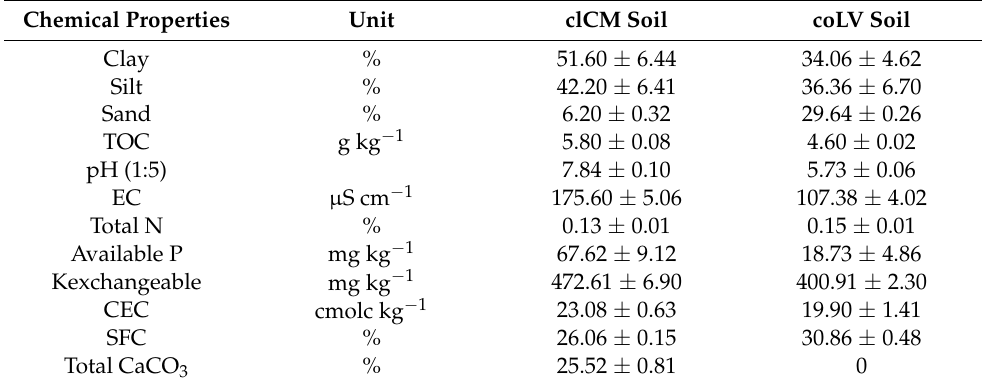
Table 1. The physicochemical characteristics of initial soils collected from the experimental fields.